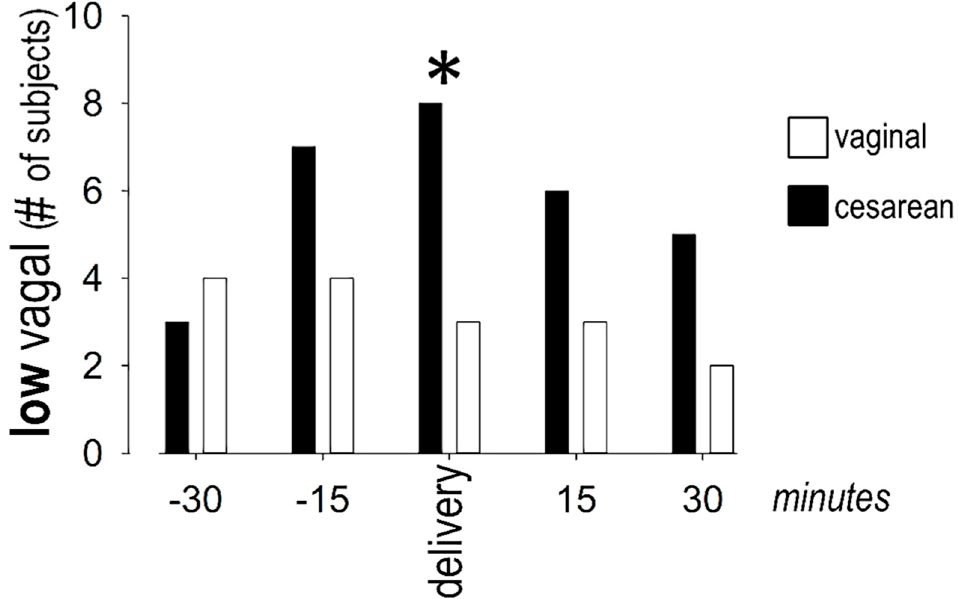
Figure 6. More women had extremely low vagal activity at the time of cesarean than vaginal delivery (asterisk, denoting significant ( p < 0.05) difference between groups.).